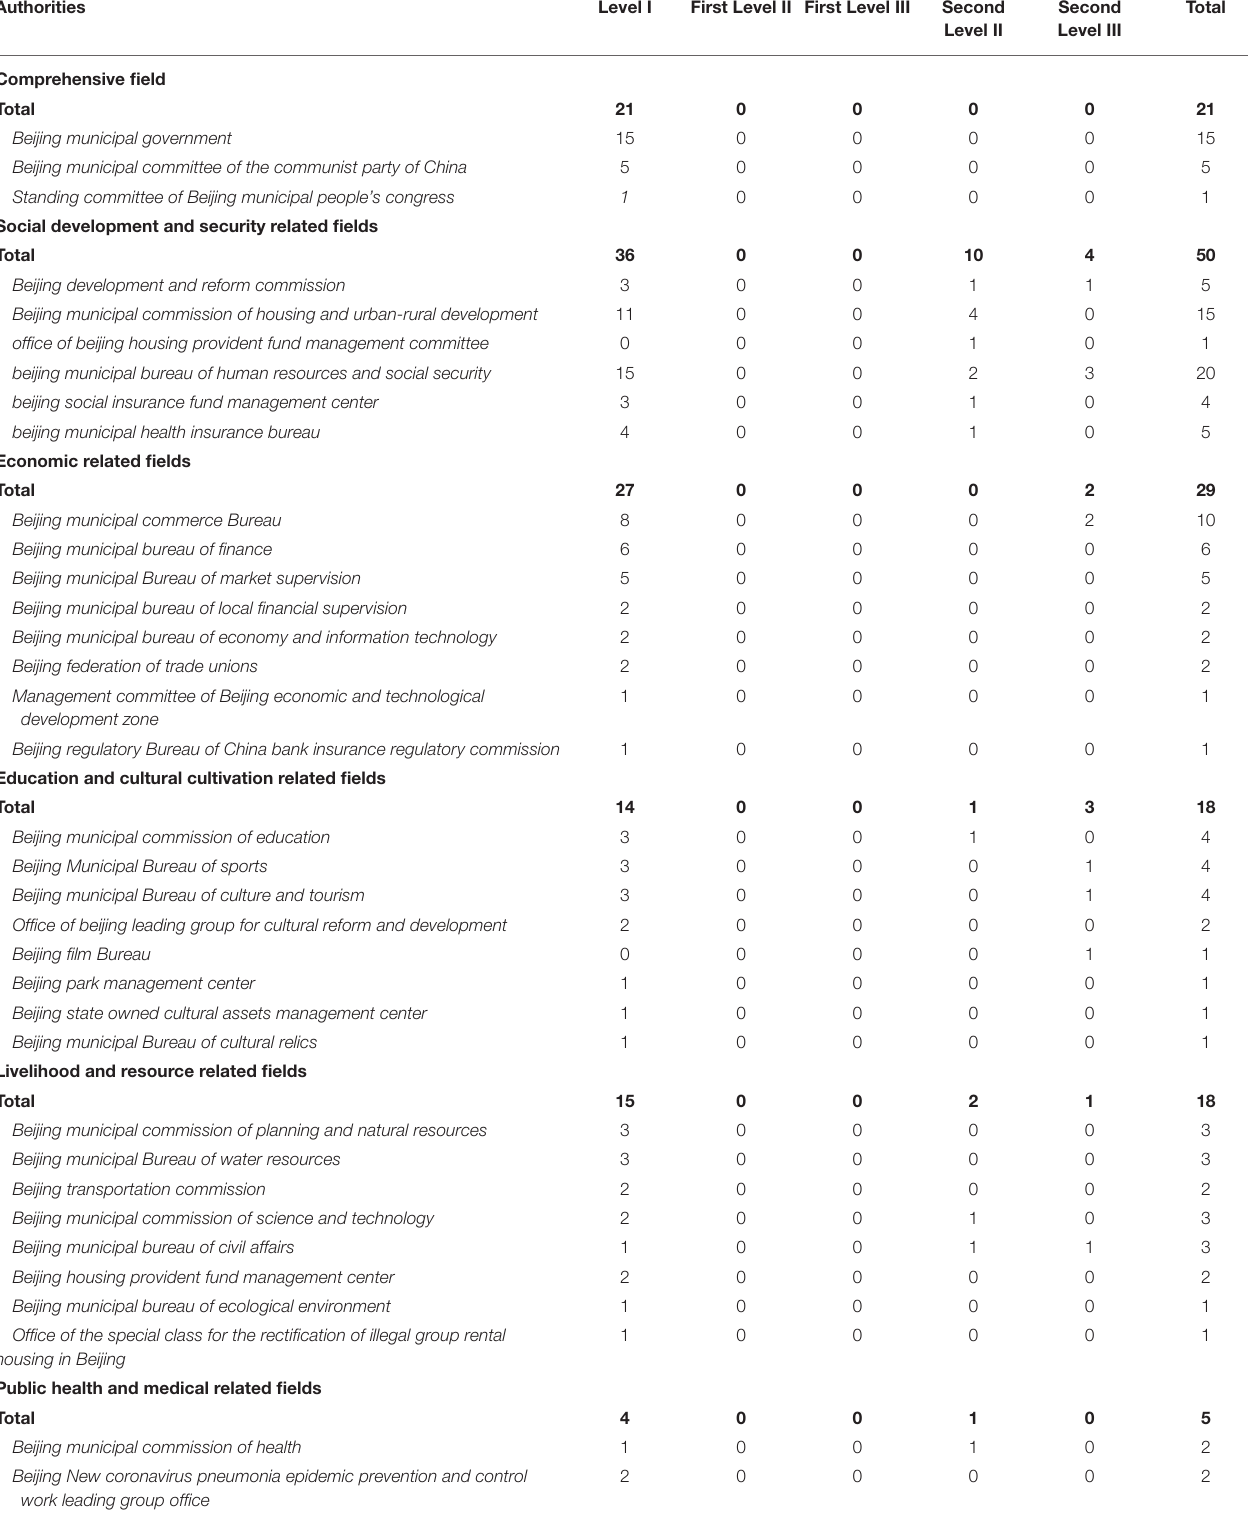
TABLE 2 | Information on policy documents issued by the Beijing municipal government and related departments on the official website during the COVID-19 in 2020.